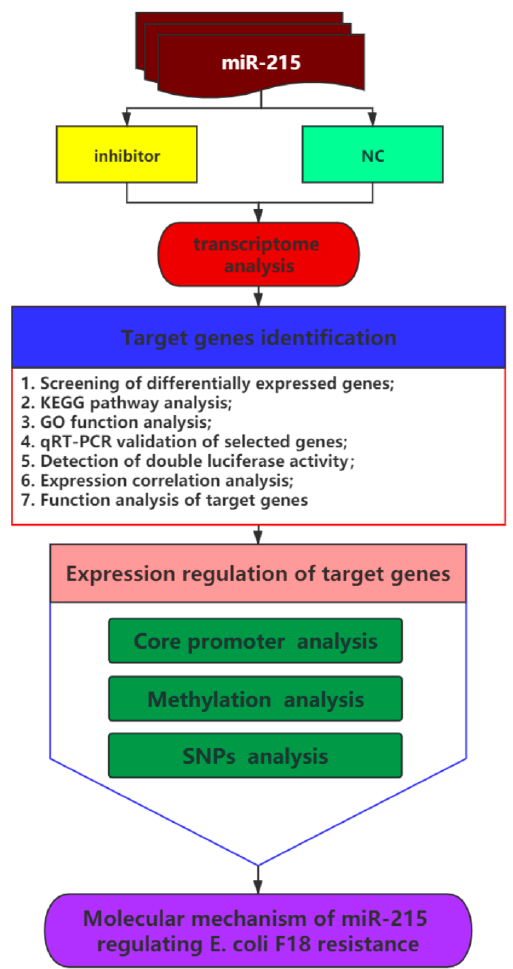
Figure 1. The overall flow of this study (Abbreviations: NC, negative control; KEGG, Kyoto Encyclopedia of Genes and Genomes; GO, Gene Ontology; qRT-PCR, real-time quantitative PCR; SNPs, single nucleotide polymorphisms; E. coli , Escherichia coli ).